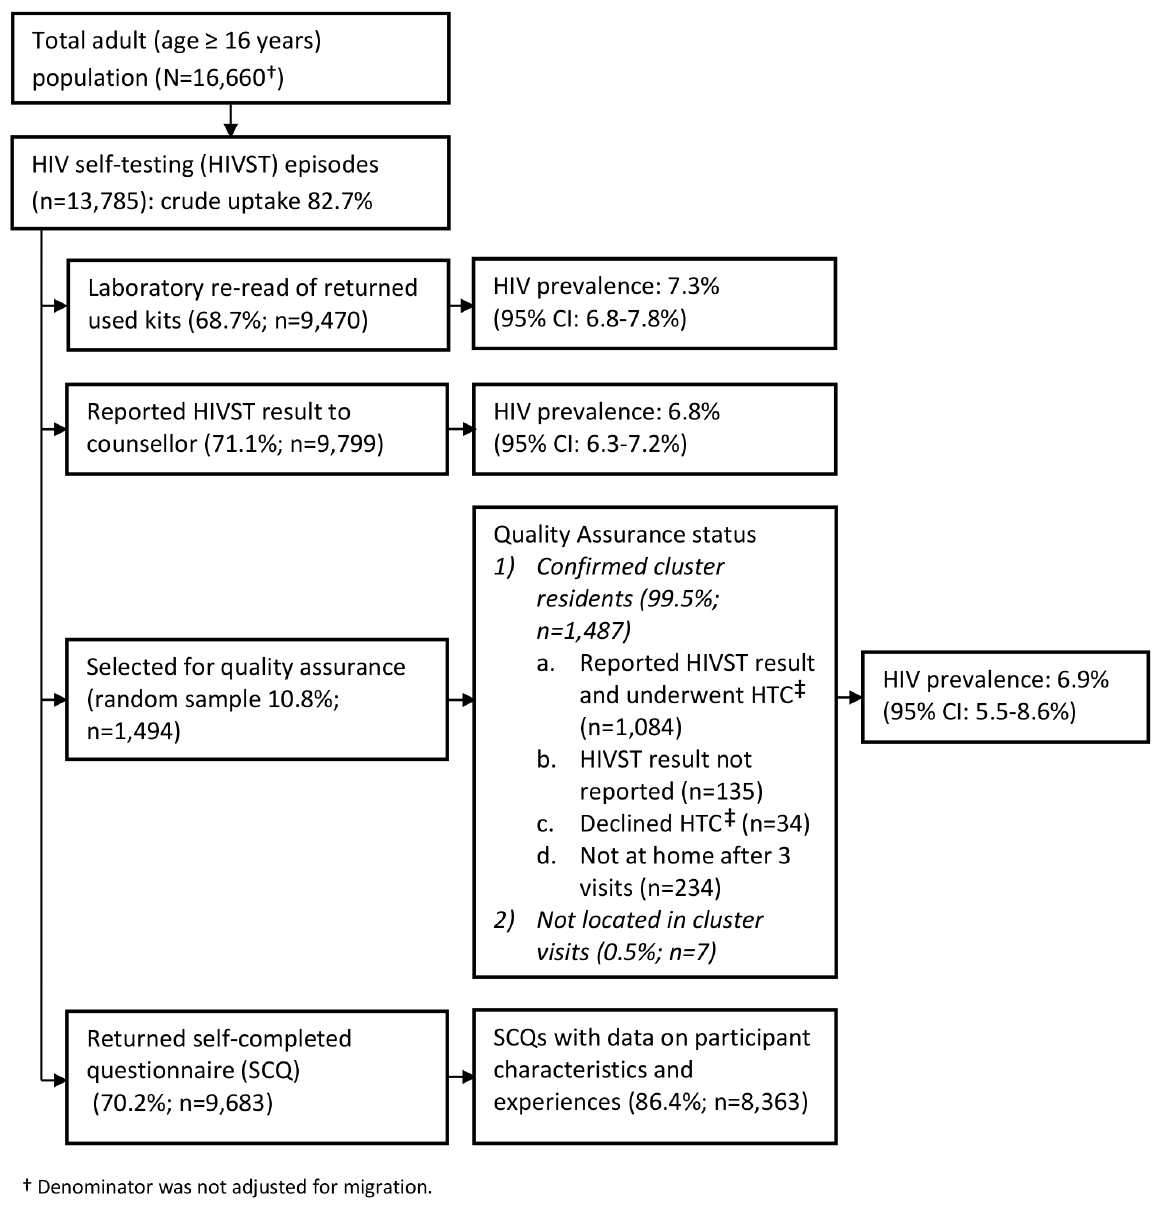
Fig 2. Flow of study participants in months 13 – 24 of HIV